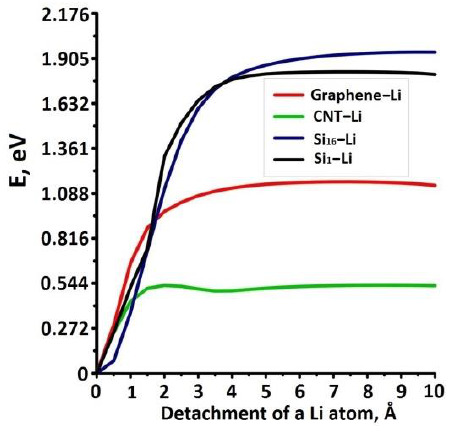
Figure 5. Binding energy if Li atom with components of the anode material.